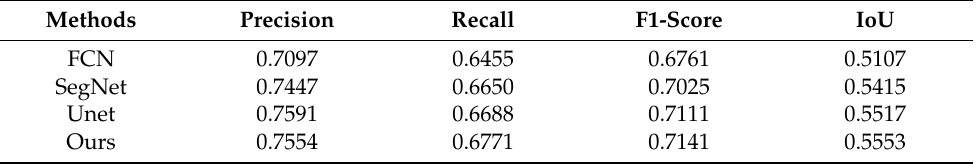
Table 2. Experimental results of road surface extraction with different networks.